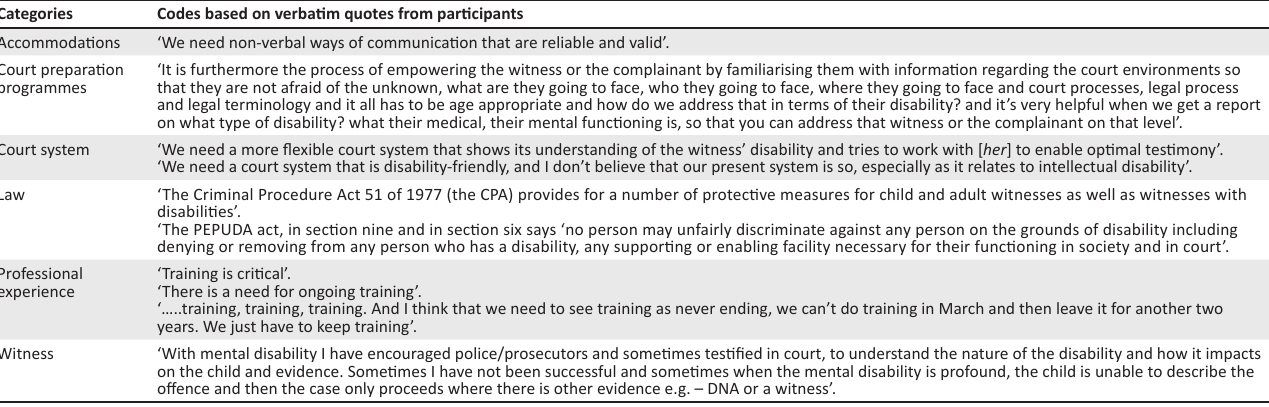
TABLE 3: Examples of codes (quotes) in specific categories. Categories Codes based on verbatim quotes from participants Accommodations